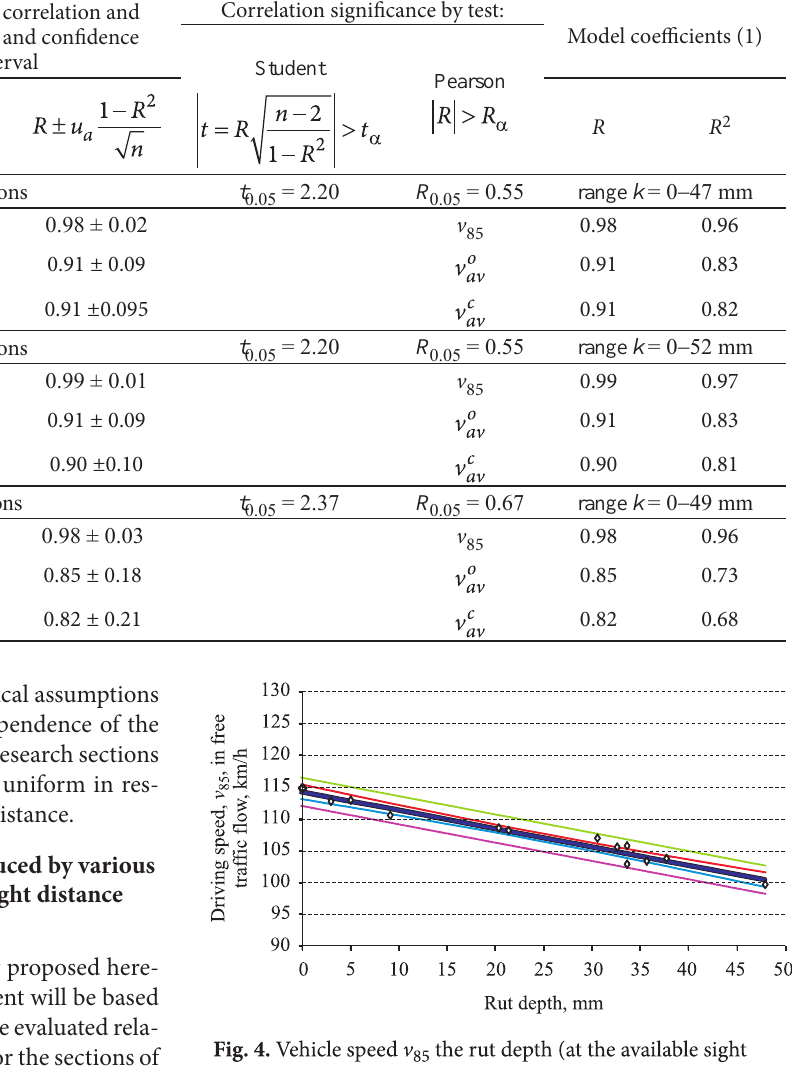
Correlation significance by test: Model coefficients (1) Student Pearson